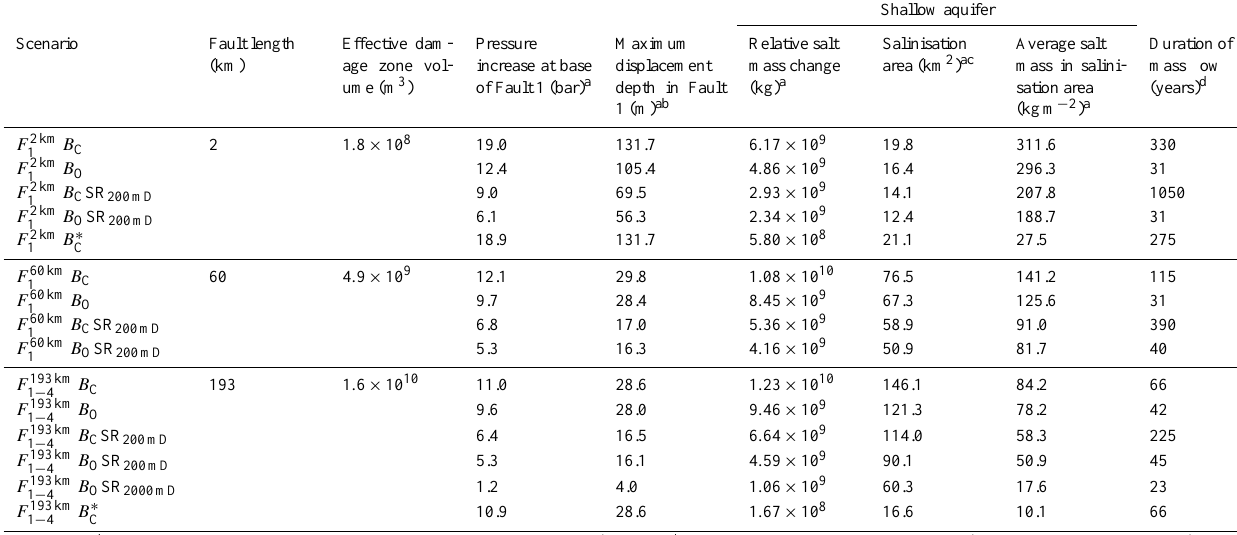
Table 3. Overview of all calculated scenarios assuming a fault permeability of 700mD. Maximum pressure increase at the base of Fault 1 and displacement depths in Fault 1 are observed at the central part of the fault.